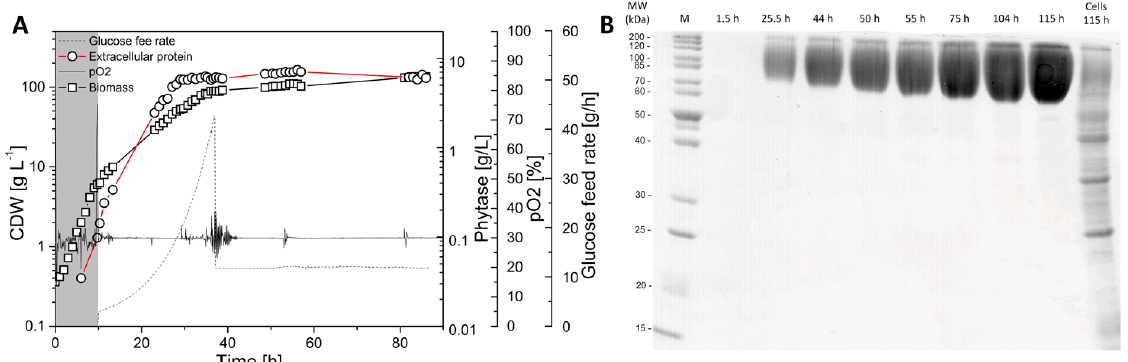
Figure 2. Production of consensus phytase with H. polymorpha RB11 conphys. ( A ) High cell density, glucose-limited fed-batch cultivation of H. polymorpha RB11 conphys with glucose as the sole carbon source in SYN-6 high cell density mineral medium. After an initial batch phase, an exponential glucose fed batch was applied to initiate the production phase. The specific growth rate µ of the cells was limited by the glucose feed to ensure continuous activity of the FMD promoter system. A final protein concentration of 7.4 g L − 1 was reached. Glucose feed rates, pO 2 , biomass, and protein titers were followed for 85 h of cultivation time. ( B ) SDS-PAGE of untreated, extracellular cultivation supernatants from high cell density, glucose-limited fed-batch cultivation of H. polymorpha RB11 conphys. Based on a densitometry analysis, the protein purity of consensus phytase in the supernatant was determined as 97%. Glycosylation of the protein resulted in increased molecular weight of the consensus phytase, resulting in band smearing. The lanes correspond to the respective sampling time points in the course of cultivation. The lane to the very right was loaded with cell extract. (M = Marker protein ladder).